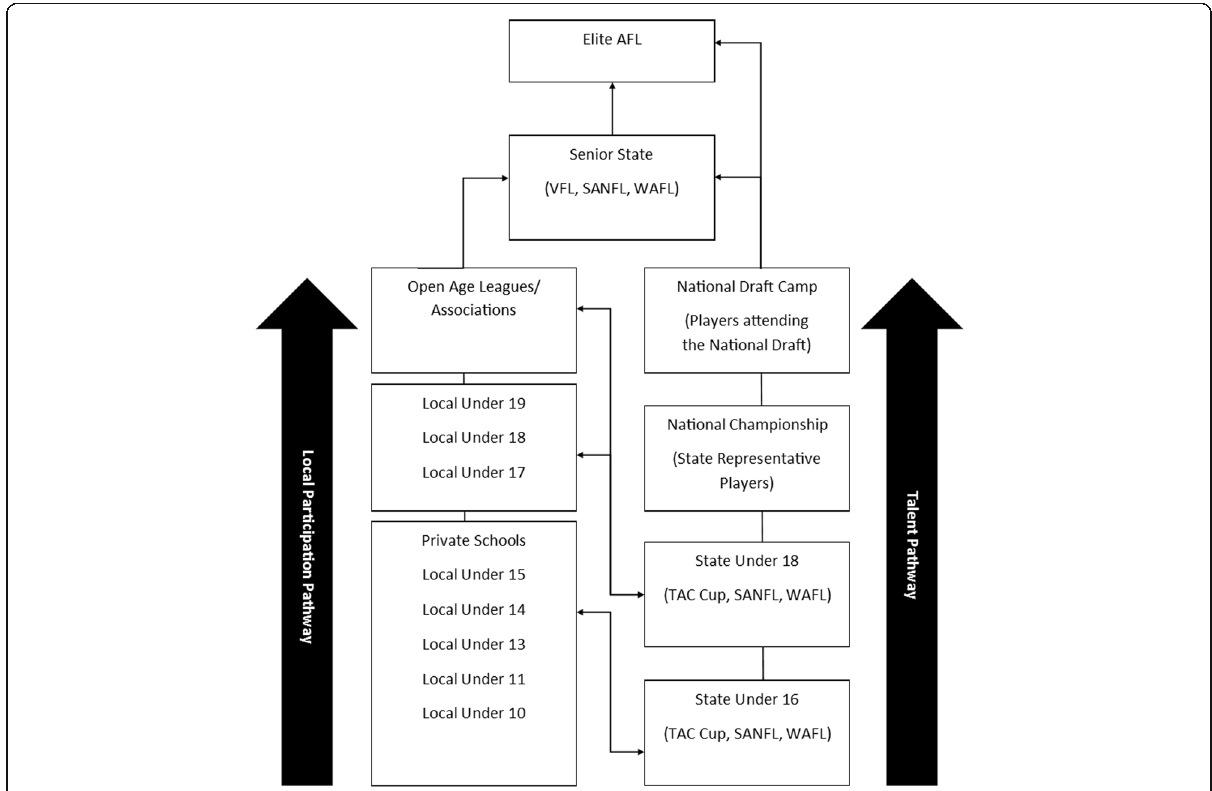
Fig. 1 The AFL participation pathway adapted from AFL Development [42, 43]. AFL Australian Football League, TAC Transport Accident Commission (Victorian State Junior Football League), VFL Victorian Football League, SANFL South Australian National Football League, WAFL Western Australian Football